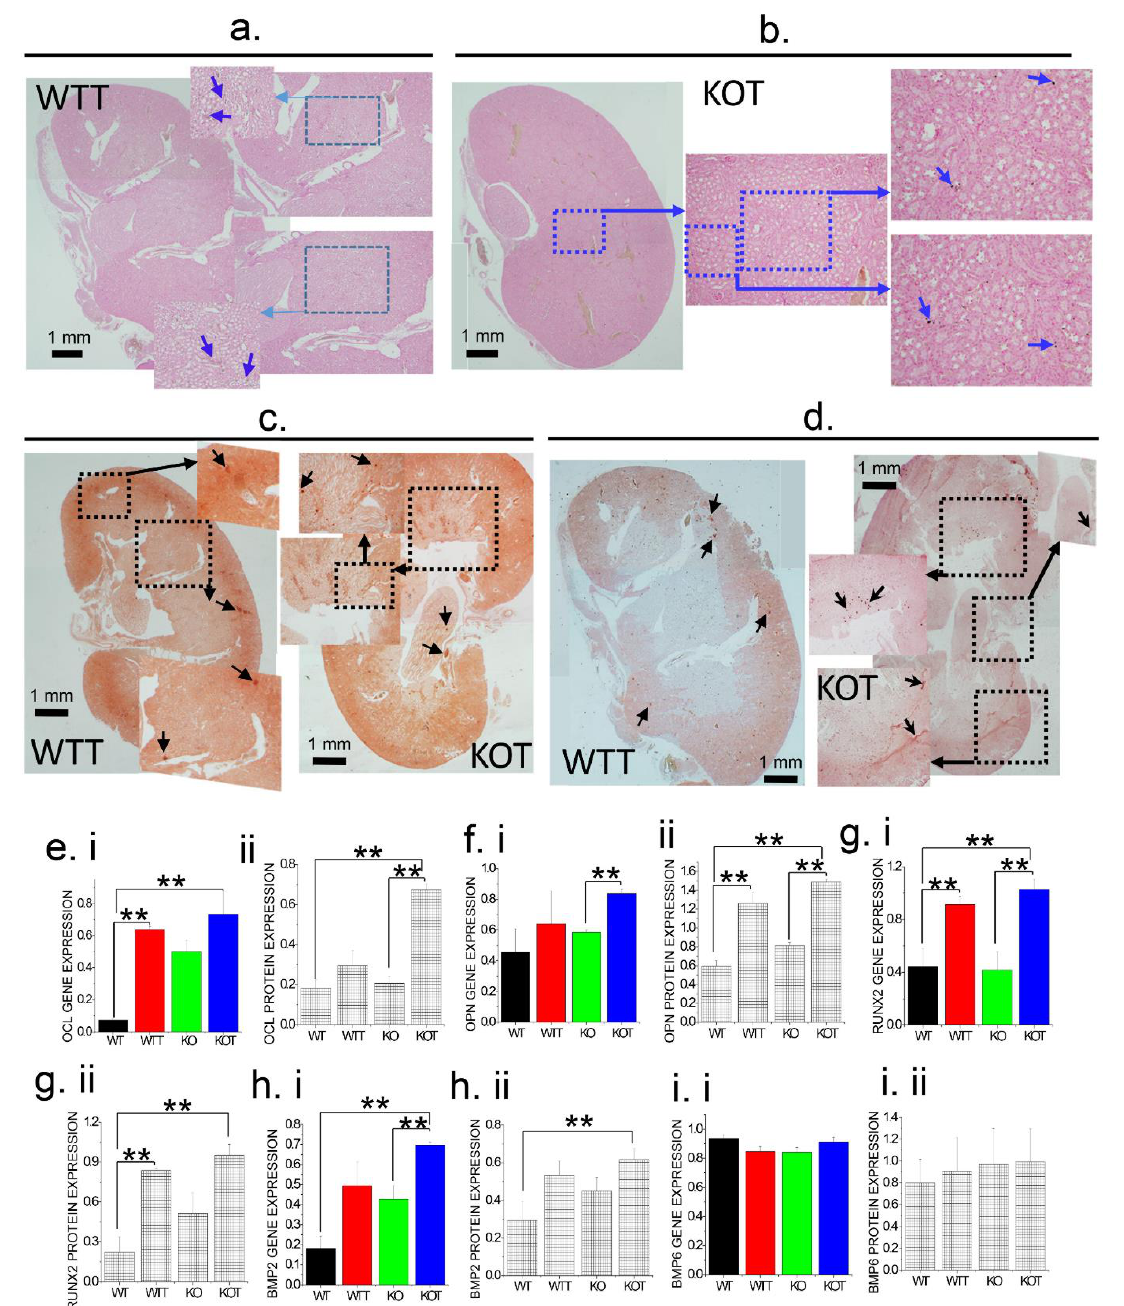
Figure 5. Histological and molecular characterization of kidney calcification and stone formation following Acz treatment. Evidence of kidney calcification and stone formation by examining kidney tissues and its underlying molecular analysis through gene/protein expression of calcification markers. ( a , b ) Representative Von Kossa staining (for CaP) of whole kidney sections of WTT and KOT showing calcified regions of the kidney indicated by blue arrows. ( c ) Alizarin Red (AR) staining of whole WTT and KOT kidney sagittal sections of AR pH 4.3 staining shows CaP stones present in the LOH region of whole kidney while ( d ) AR pH 6.8 shows CaP+CaOx (mixed) stones in the calyx region of WTT and KOT whole kidney. Gene/Protein expression analysis providing evidence PT cell calcification in treated mice are shown by expression profiles of known calcification markers; ( ei , eii ) OCL, ( fi , fii ) OPN, ( gi , gii ) RUNX2 and ( hi , hii ) BMP2, which are significantly higher for the treated groups especially for KOT compared to the controls (WT and KO), except for ( ii,iii ) BMP6 which did not show any significant difference between the treated and untreated groups. ( e–i ) Bar graphs quantifications are means ± SEM, ( n = 3); **, p < 0.01. All gene and protein expressions are normalized to GAPDH and β -actin